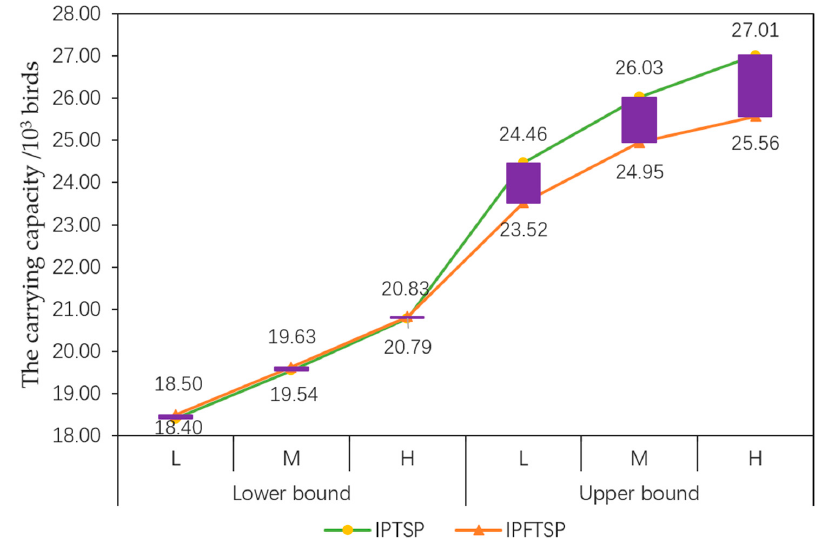
Figure 5. Comparison of the recovered carrying capacity for rare migratory water birds between the IPFTSP and IPTSP models under different flood flow scenarios. L, M, and H denote low, middle, and high flood flow scenarios,